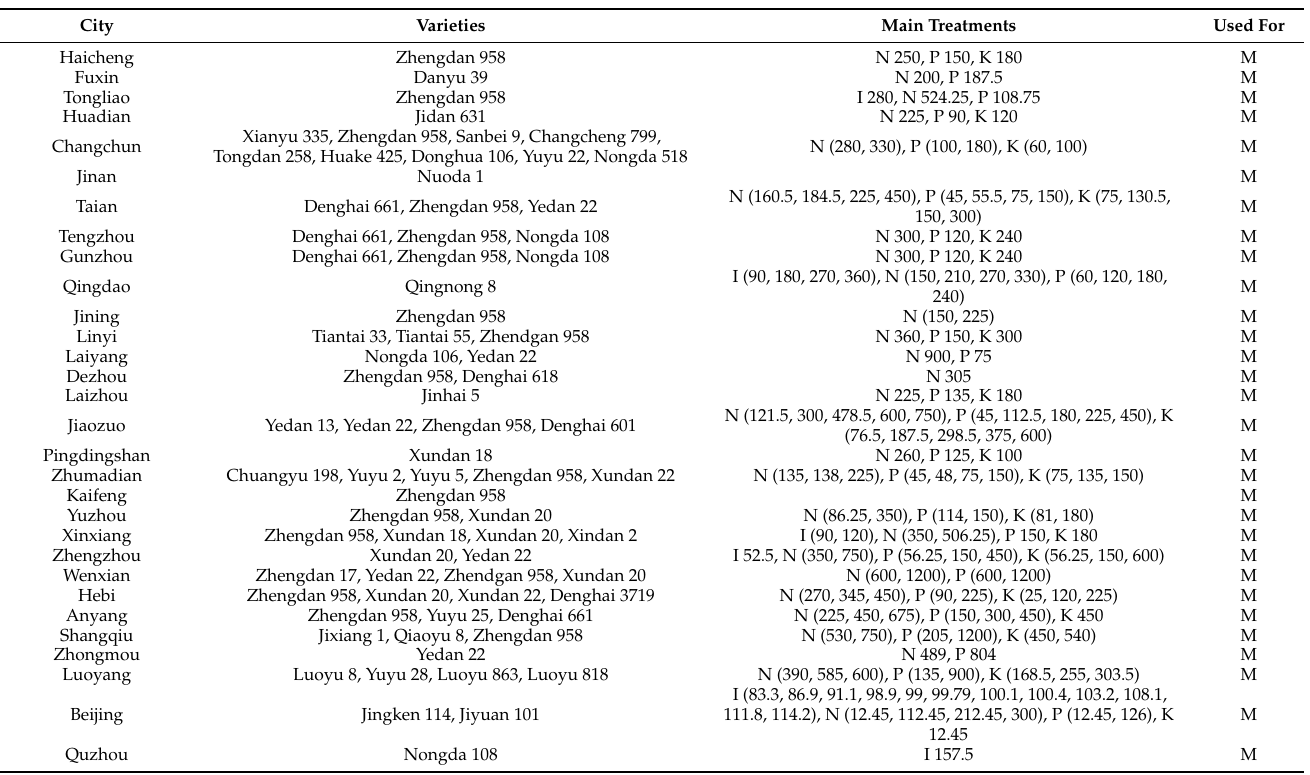
Table 4. Varieties and Main Treatments at Each Site for Summer Maize in China. N, N